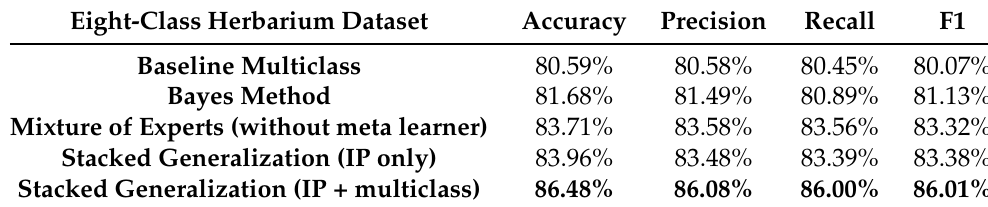
Table 4. Evaluation metrics for the eight-class herbarium dataset. The highest accuracy metrics are highlighted using bold.